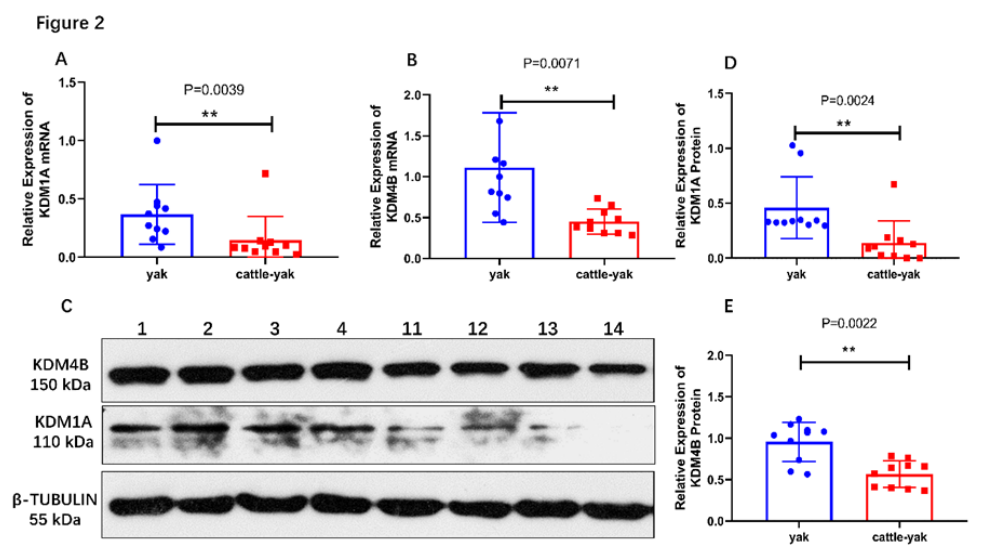
Figure 2. KDM1A and KDM4B expression in the testes of yaks and cattle–yaks. ( A ) The relative expression of the KDM1A mRNA was detected by Real-time PCR; GAPDH and 18S RNA were used as reference genes. Test for normal distribution (P yak = 0.0651, P cattle-yak < 0.0001). ( B ) The relative expression of the KDM4B mRNA was detected by Real-time PCR; GAPDH and 18S RNA were used as reference genes. Test for normal distribution (P yak = 0.0534, P cattle-yak = 0.3304). ( C ) The expression of KDM1A and KDM4B proteins was detected by Western blotting. β - Tubulin was used as reference gene. Lane 1–4 are yaks and lane 11-14 are cattle-yaks. ( D ) The relative expression of the KDM1A protein between yaks and cattle–yaks. Test for normal distribution (P yak < 0.0001, P cattle-yak = 0.0005). ( E ) The relative expression of the KDM4B protein between yaks and cattle–yaks. Test for normal distribution (P yak = 0.0509, P cattle-yak = 0.2195). ** p < 0.01.